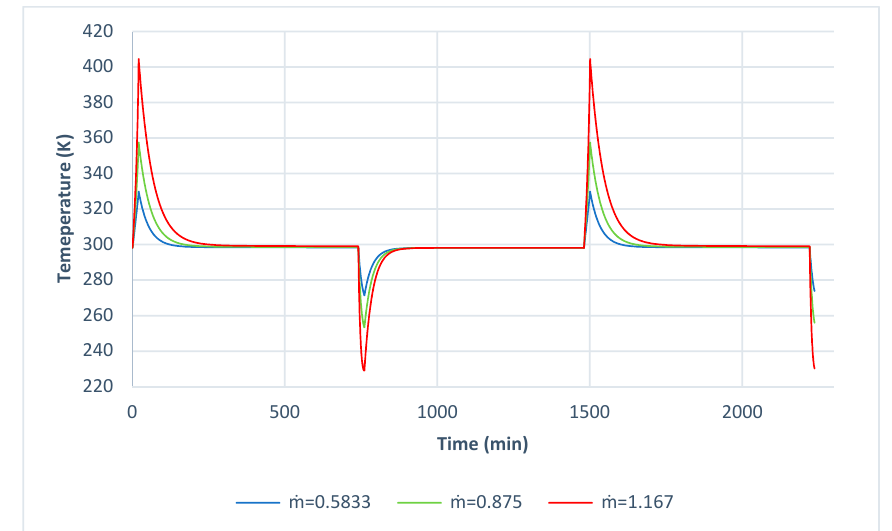
Figure 4. The gas temperature trend for the First Configuration varying the liquid flow rate. Energies 2018 , 11 , 3405